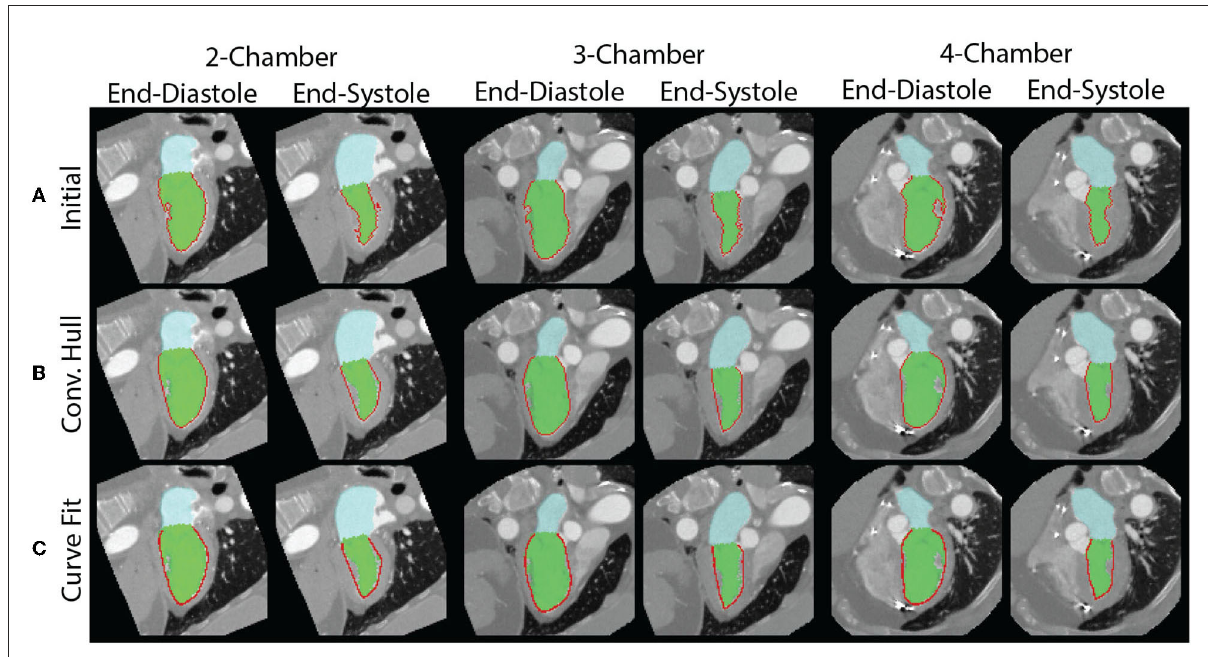
FIGURE3 Measurement of endocardial perimeter based on the blood pool segmentation is susceptible to artifacts created by the papillary muscles. (A) The papillary muscles create indentations which impact the measurement of the perimeter. The end-diastolic (left) and end-systolic (right) perimeters for each of the views are shown. They are all overestimated. (B) By modeling the blood pool as a convex hull, we can correct for the errors from indentations created by papillary muscles. However, the perimeter measurement remains affected by the perimeter’s texture. (C) Fitting of a curve to the perimeter avoids issues related to the surface